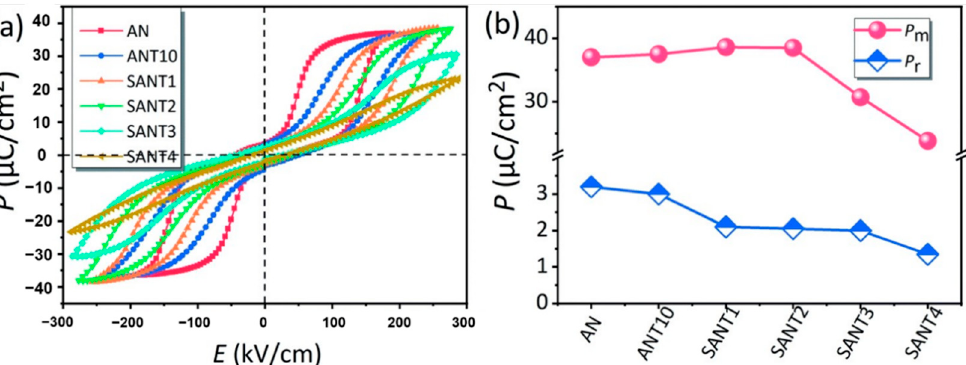
Figure 17. ( a ) plots the room-temperature P–E loops of the as-sintered ceramics measured at 1 Hz, ( b ) P m and P r . Reprinted with permission from [77]. Copyright 2019 Royal Society of Chemistry.